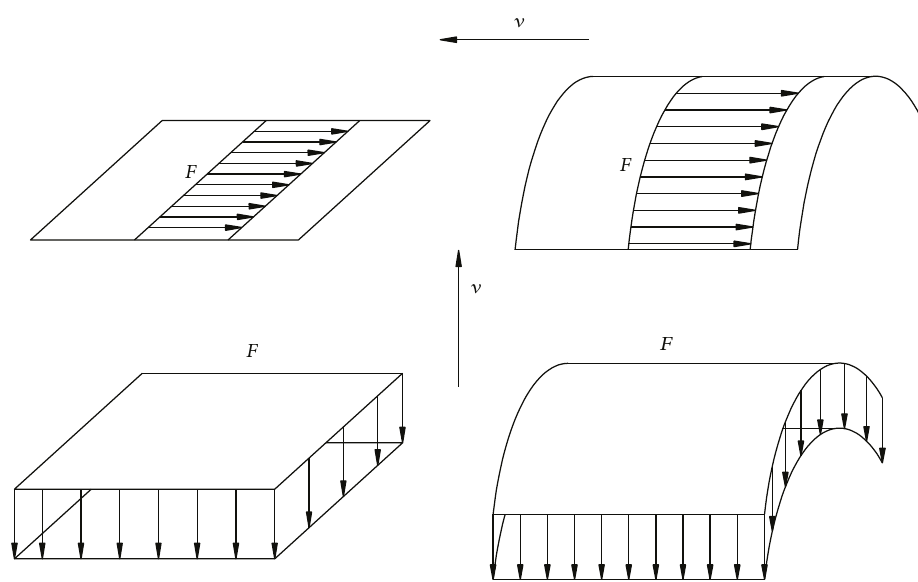
Figure 15: Coupling force analysis between the velocity and the surfaces.